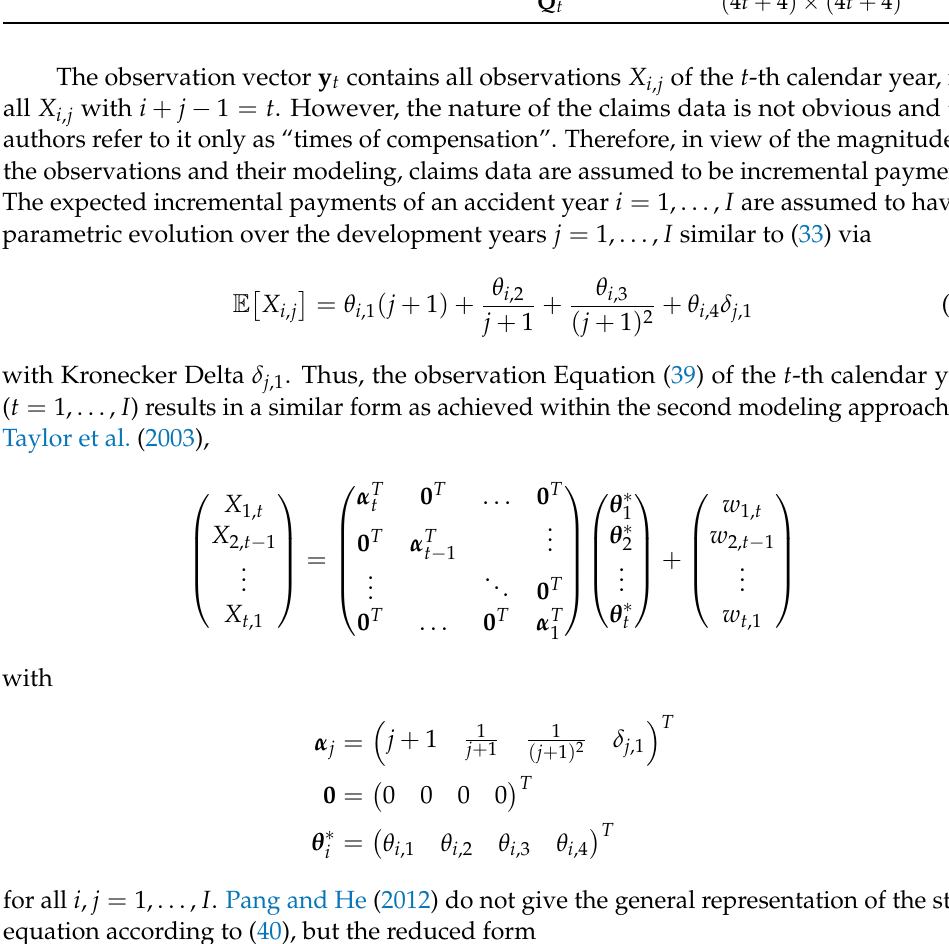
Table 3. Dimensions in the state space model of Pang and He (2012). Vectors Matrices y t t 1 G t t × x t 4 t 1 F t ( 4 t + 4 ) × w t t 1 H t ( 4 t + 4 ) × v t ( 4 t + 4 ) 1 R t t × Q t ( 4 t + 4 )